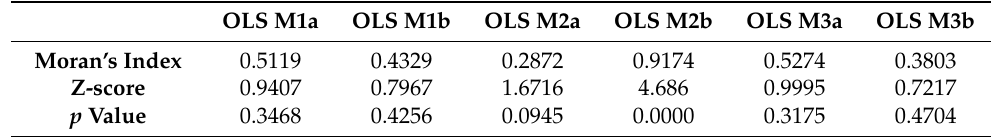
Figure 11. Population distribution for the Bursa region in the 1850s. Results for different modeling approaches. Pixel size: 30 × 30 m. From top left to bottom right: ( a ) Method: Probability map, compact model ( b ) Method: Probability map, dispersed model ( c ) Method: OLS1, dispersed model (pop < or =250) ( d ) Method: OLS2, dispersed model (pop > 250) ( e ) Method: GWR3, dispersed model. Table 6. Results from spatial autocorrelation statistics for the OLS